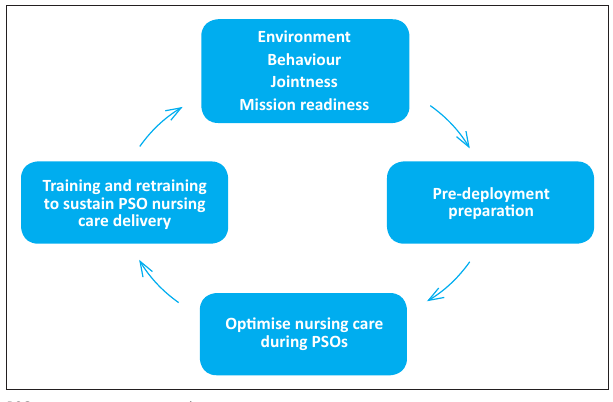
FIGURE 1: The cycle of pre-deployment preparation for